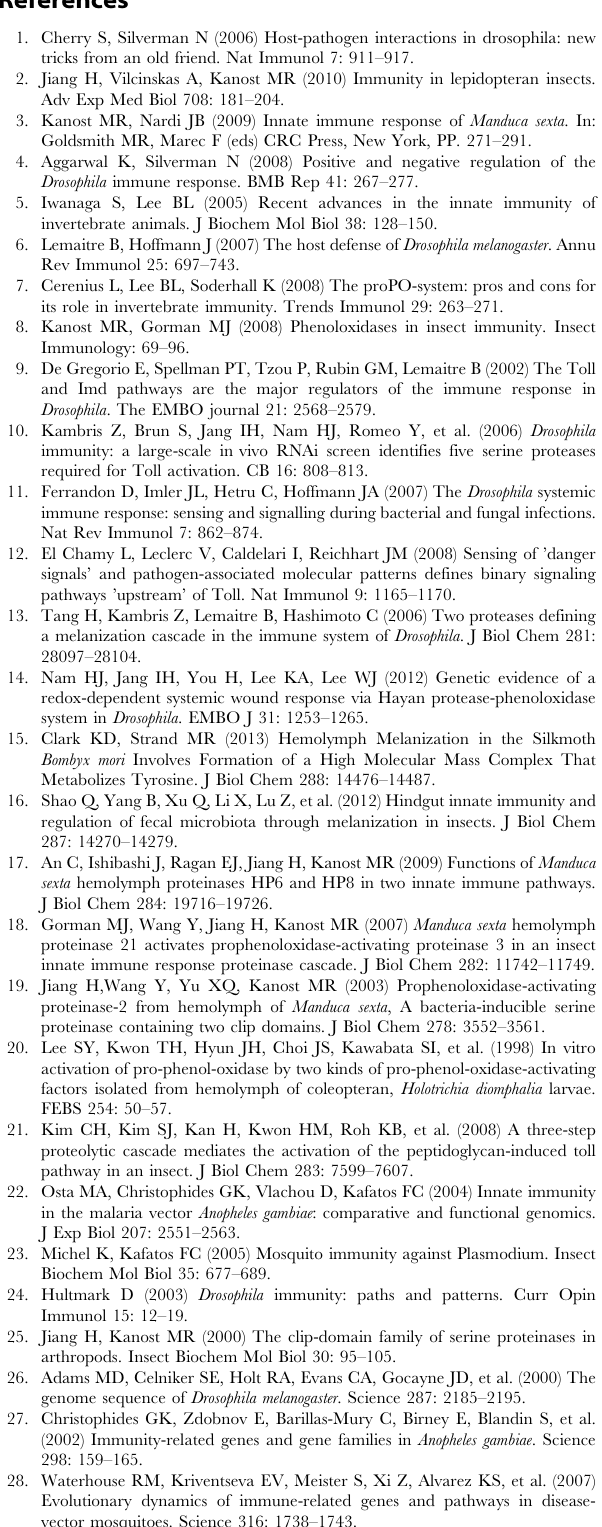
Table S5 The ID, length, expression and functional annotation of each differently expressed